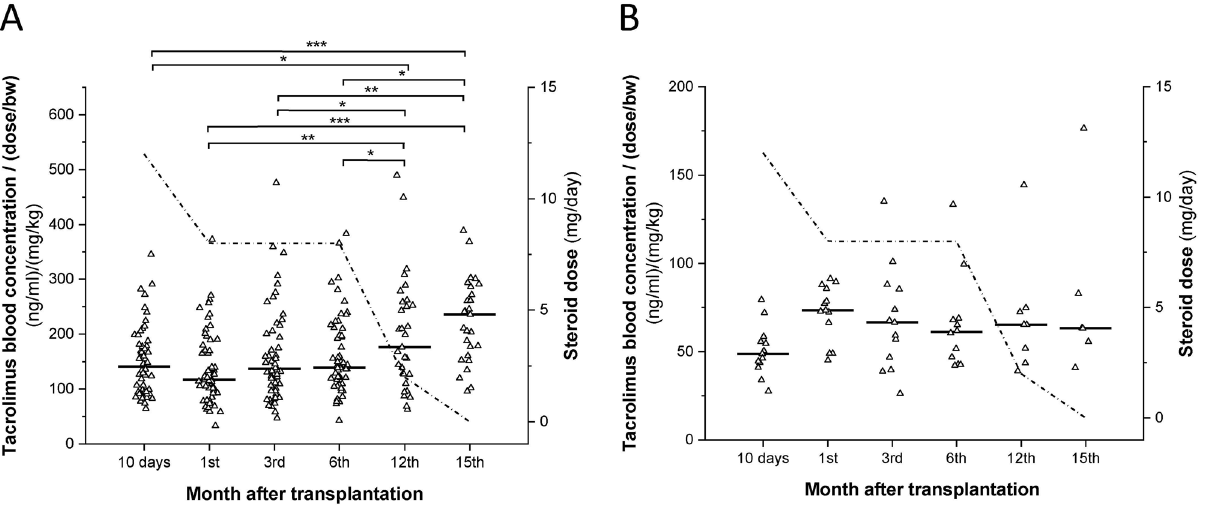
Figure 3. The dose-corrected tacrolimus blood concentrations in heart transplant recipients carrying CYP3A5*3/*3 genotype ( A ) and CYP3A5*1 allele ( B ) in a 15-month period after transplantation. The dotted line represents the daily dose of corticosteroid. *P < 0.05, **P < 0.001, ***P <